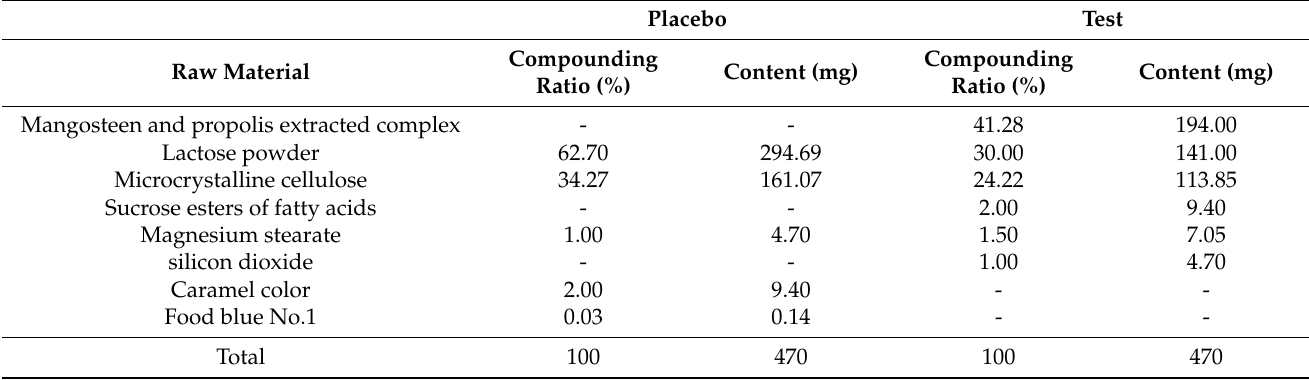
Table 1. The details of the constituents of the test and placebo